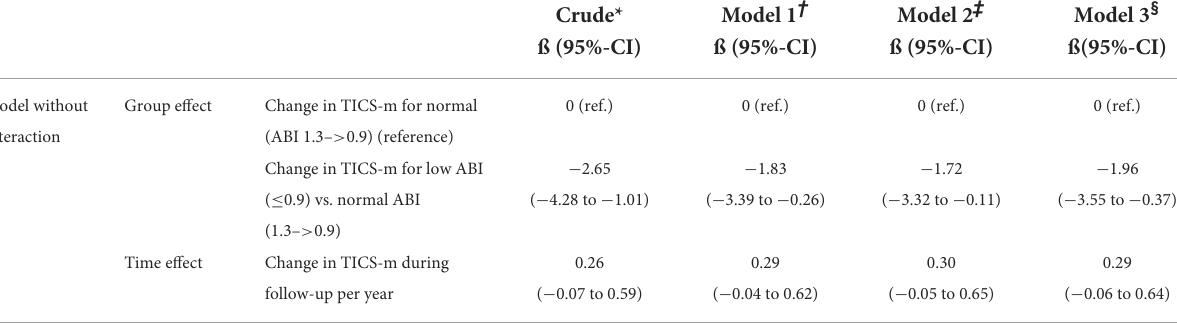
TABLE 2 Association of normal ( > 0.9) vs. low ( ≤ 0.9) ABI with cognitive function based on TICS-m over a 3-year